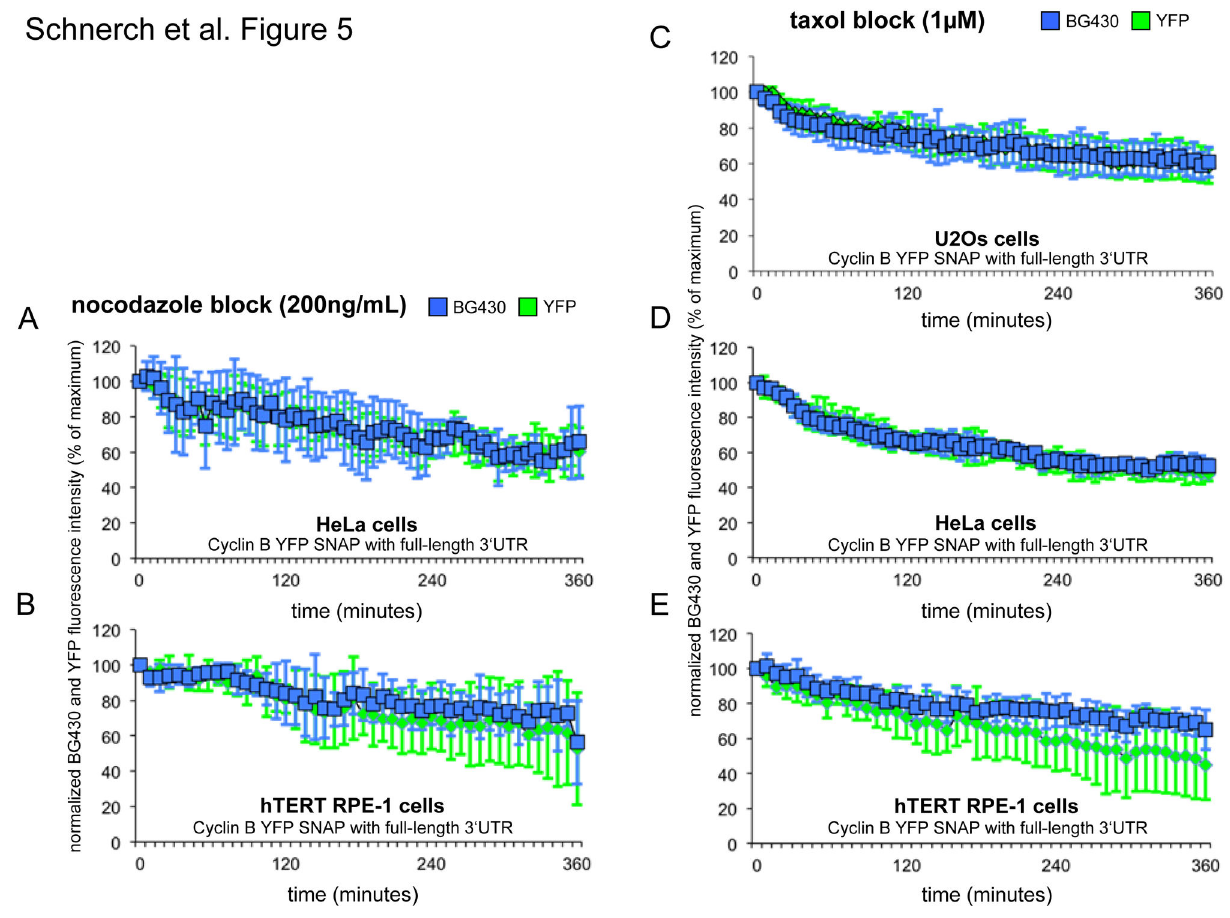
Figure 5. Characterization of cyclin B kinetics in the presence of the cyclin B 3’ UTR in human tumor- and hTERT- immortalized cells and in the presence of the microtubule-stabilizer taxol. YFP and BG430 fluorescence intensity curves as determined by live-cell imaging of U2Os, HeLa and hTERT RPE-1 cells expressing the CYS reporter with a long 3’ UTR sequence. HeLa and hTERT RPE-1 cells that are arrested in a mitotic block using a final nocodazole concentration of 200ng/mL in the growth medium are depicted in (A) and (B) (mean fluorescence intensities +/- SD are indicated, n=4). U2Os, HeLa and hTERT RPE-1 cells that are arrested in a mitotic block using a final taxol concentration in the growth medium of 1µM are depicted in (C, D and E) (mean fluorescence intensities +/- SD are indicated, n=4). For every shown experimental setting the analyzed cells are representatives of three independent experiments each of which included at least 50.000